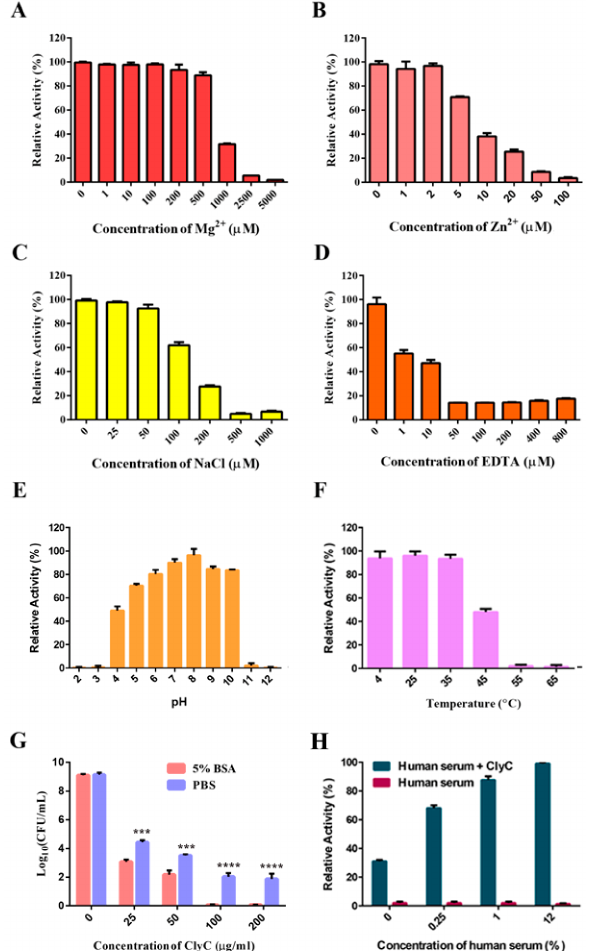
Figure 3. Physicochemical properties of ClyC. Effects of Mg 2+ ( A ), Zn 2+ ( B ), NaCl ( C ), EDTA ( D ), pH ( E ), temperature ( F ), PBS containing 5% BSA ( G ), and PBS containing human serum ( H ) on the antibacterial activity of ClyC. The relative activities of ClyC (25 µ g/mL) were obtained by detecting the change of OD 600 value against S. aureus T23 under different conditions. Log killing activities of different concentrations of ClyC (0, 25, 50, 100, and 200 µ g/mL) against S. aureus T23 were determined in PBS with and without 5% BSA. All experiments were repeated three times. Error bars represent standard deviation (*** p < 0.001, **** p < 0.0001, the significance was analyzed by T tests using GraphPad Prism 7